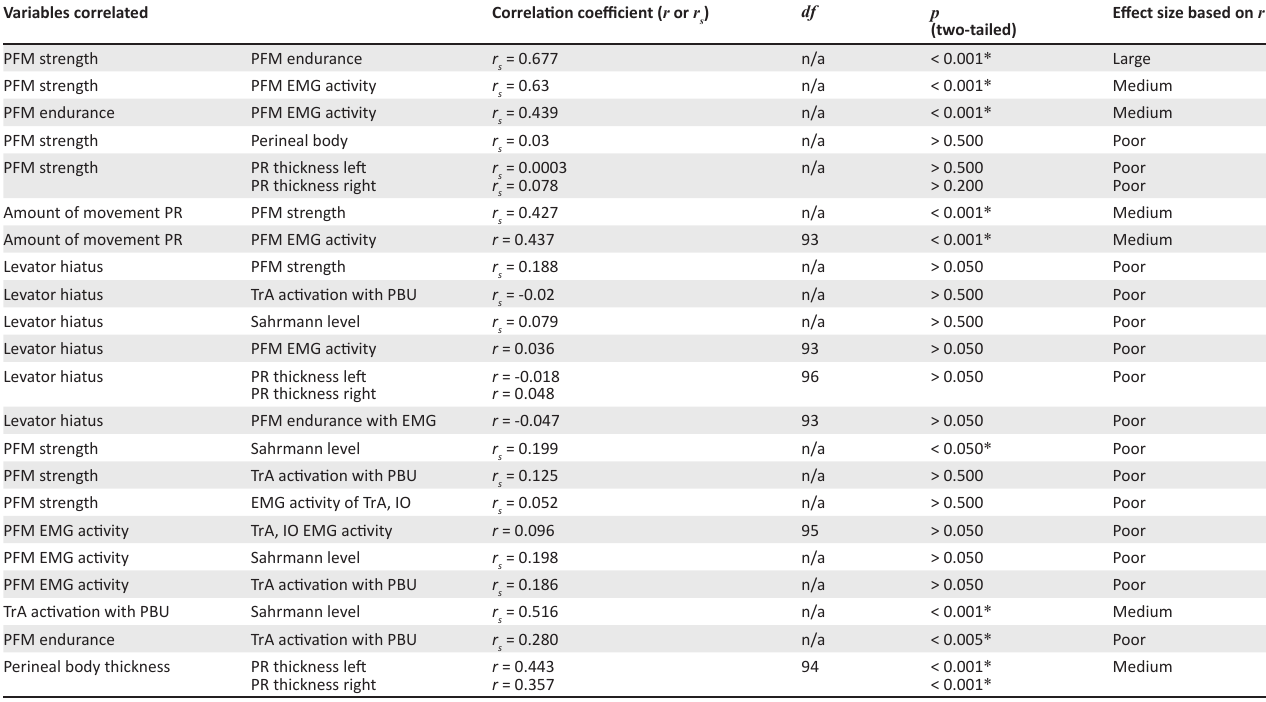
TABLE 3: Correlations between variables relating to movement impairments of the pelvic floor and abdominal muscles. Variables correlated